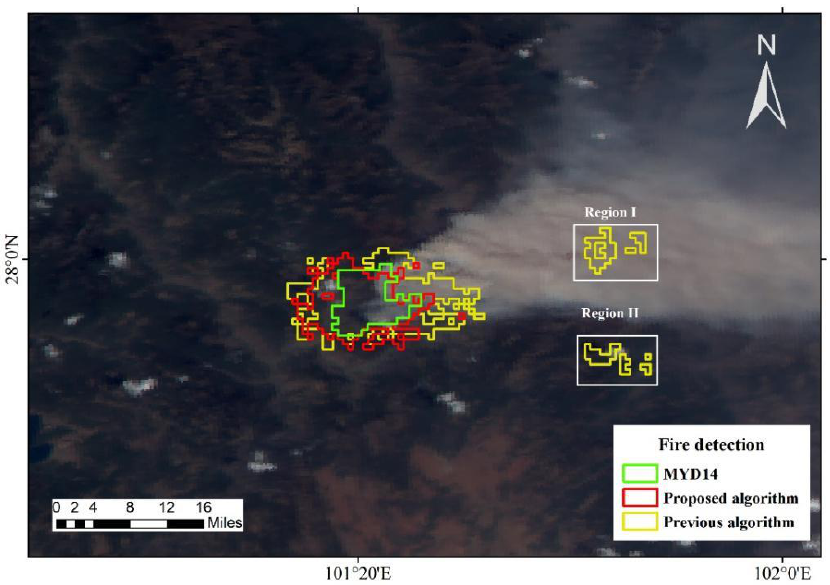
Figure 8. Comparison with previous algorithm of 30 March 2020 fire results in Sichuan, China.